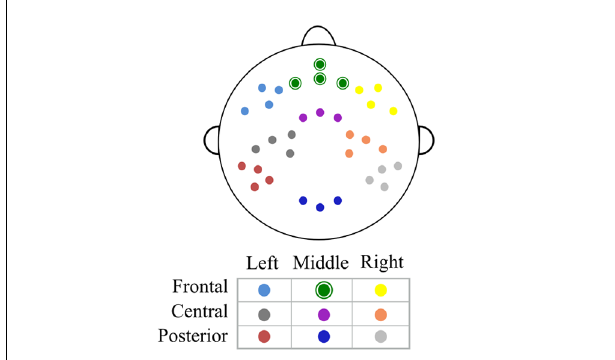
FIGURE 1 | Scalp topography of middle frontal and remaining electrode clusters. All clusters taken into analysis. Middle frontal cluster is marked with green, circled dots.